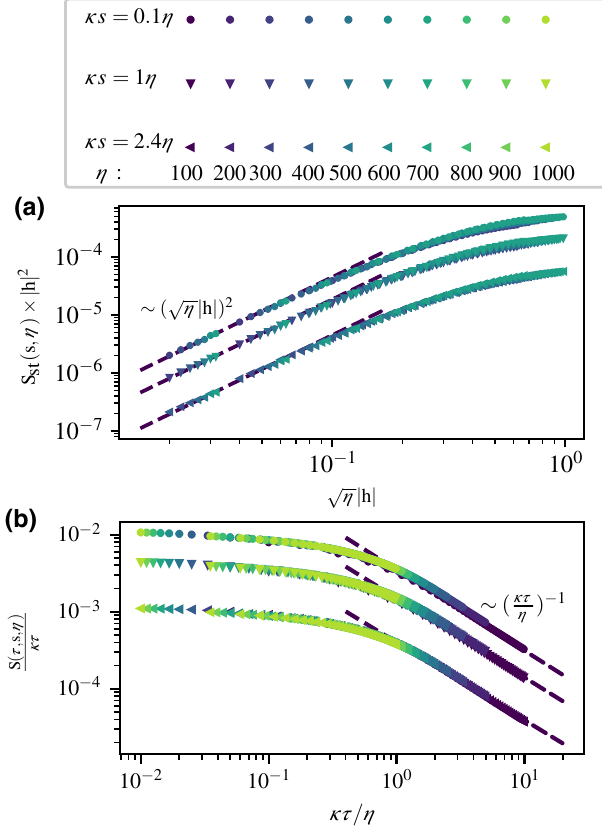
FIG. 8. Numerical verification of the dynamic scaling ansatz (9) for the open Rabi model, which has z = 1, ν = 2, and (cid:10) ˆ n = − 1 / 2. The perfect scaling collapse demonstrates the validity of Eq. (9) along the specific axis in the parameter space (see the